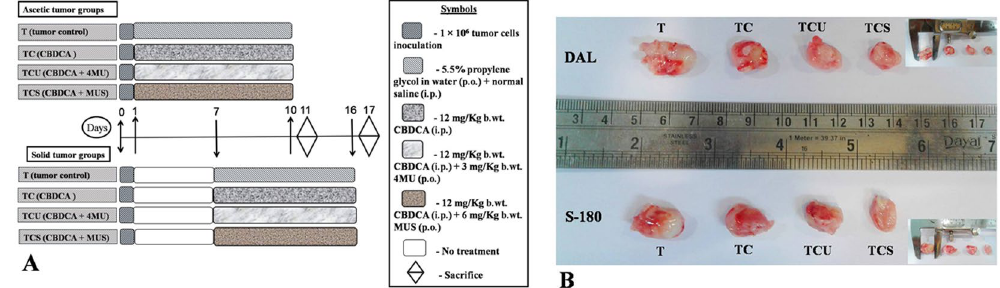
Figure 5. ( A ) Graphical presentation of different groups of mice for in vivo antitumour activity study. ( B ) Effect of 4MU and MUS in combination with CBDCA on tumour size of two different solid tumours (DAL and S-180). Measurement of tumour volume is shown in the inset.